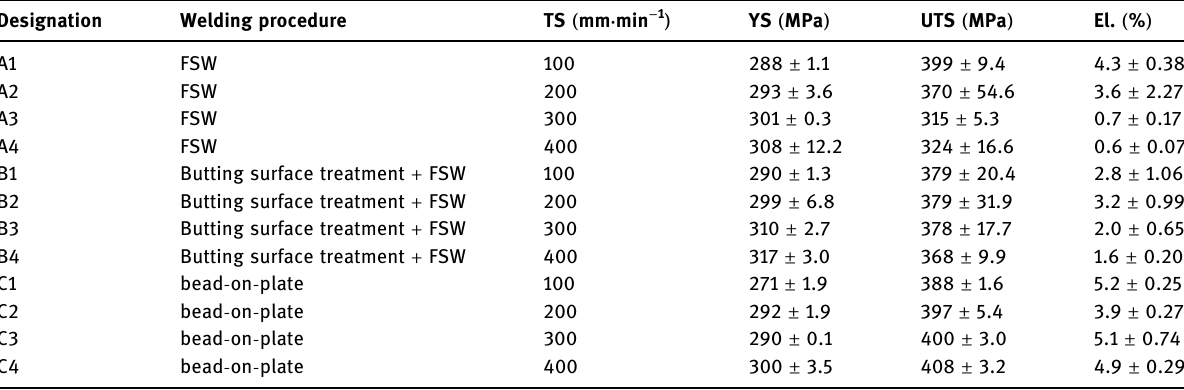
Table 2: Welding conditions applied in current study and their tensile